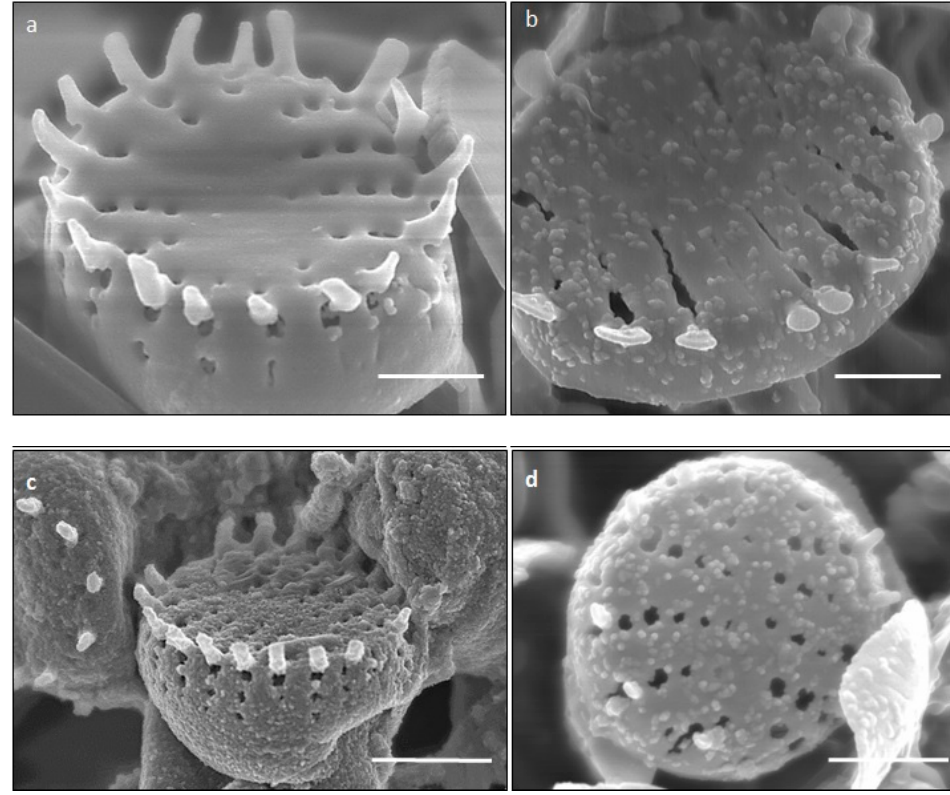
Figure 2. SEM images showing surface morphology of control ( a ) and IONPs loaded ( b – d ) frustules P. trainorii [scale bar 1 μ m].